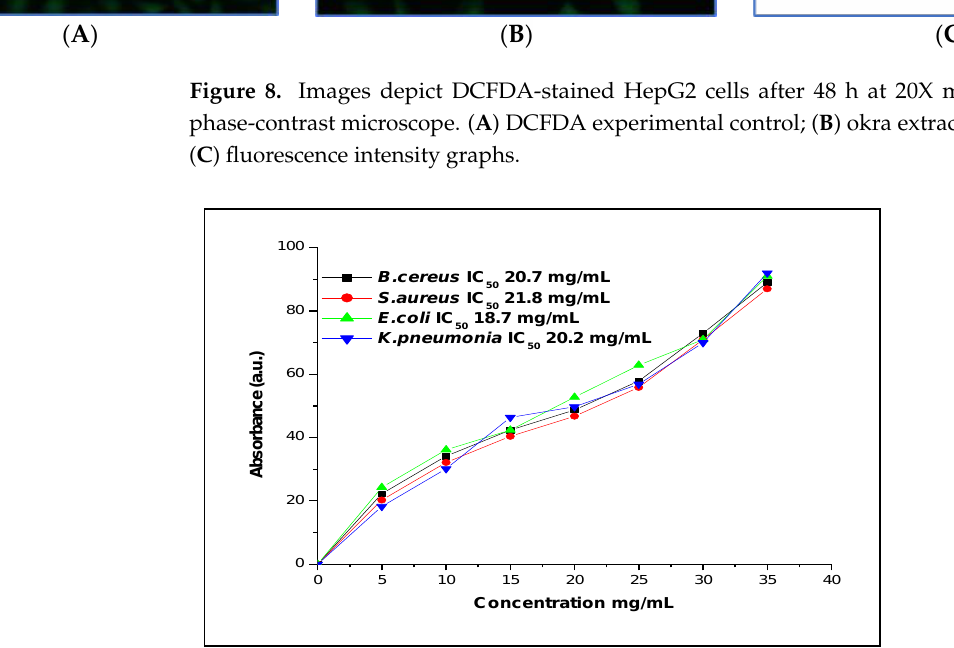
Figure 8. Images depict DCFDA-stained HepG2 cells after 48 h at 20X magnification under a phase-contrast microscope. ( A ) DCFDA experimental control; ( B ) okra extract-treated HepG2 cells; ( C ) fluorescence intensity graphs.